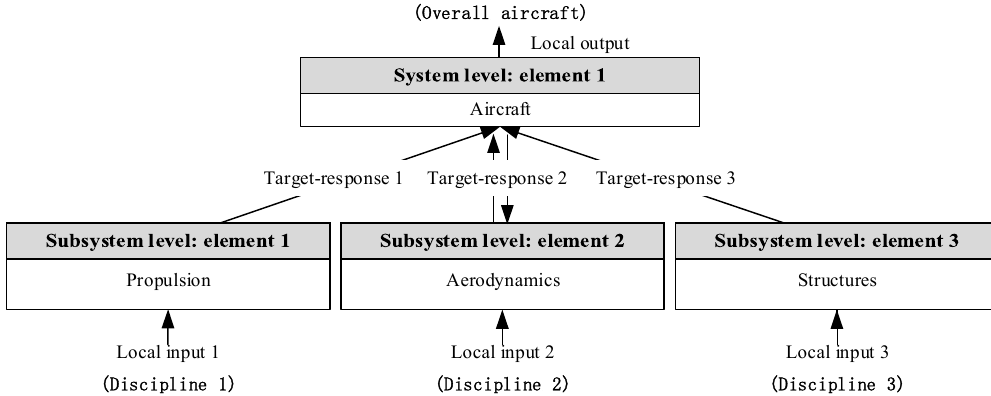
Figure 10. ATC formulations without hierarchical coupling for single-stage aircraft.